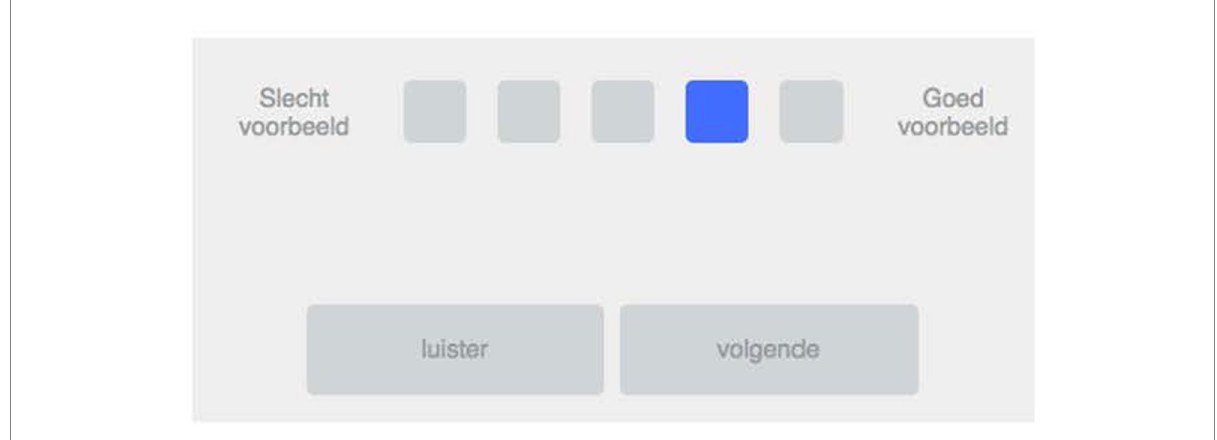
FIGURE 4 The interface used by the participants to input their ratings, with a rating of four selected, but not yet